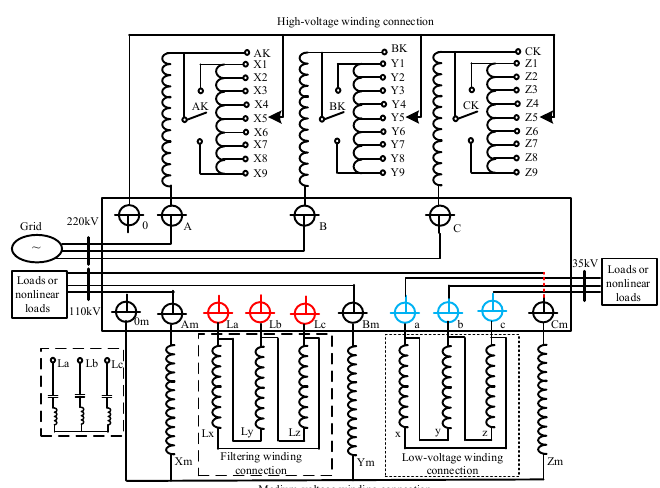
Figure 1. Main circuit topology for a high voltage (HV) distribution network with one passive filtering (unit No.1) and another inductive filtering (unit No.2). AC: alternative current; FW-IFT: four-winding inductive filtering transformer.